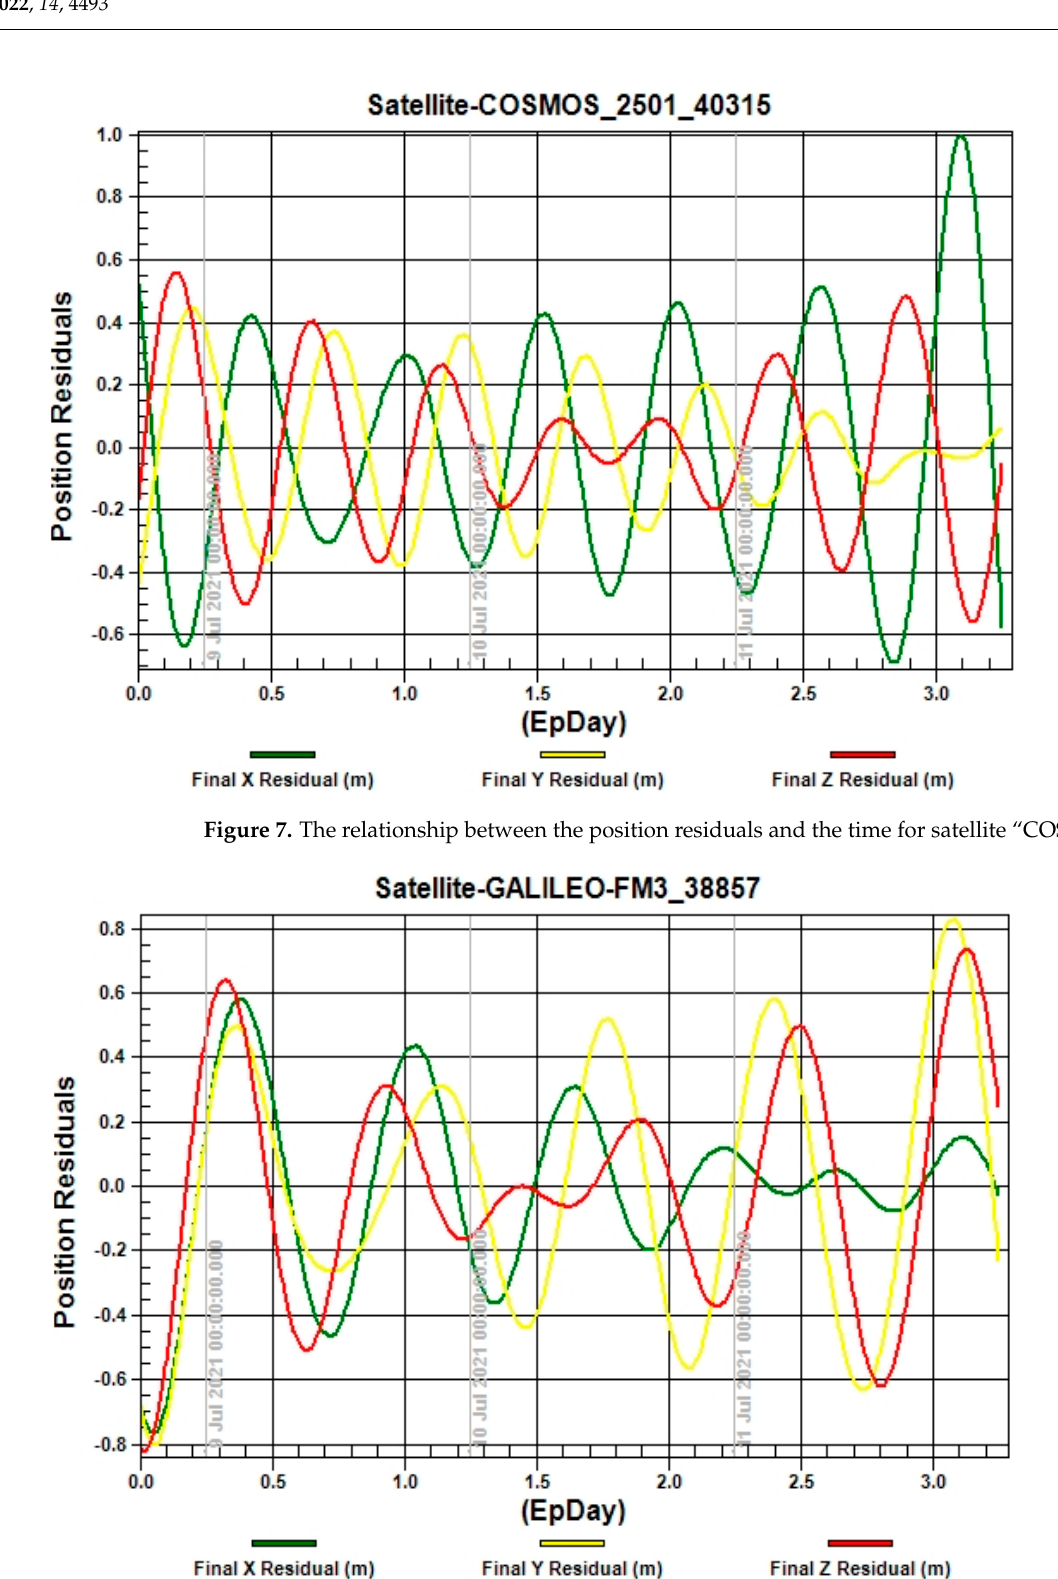
Figure 8. The relationship between the position residuals and the time for satellite “GALILEO-